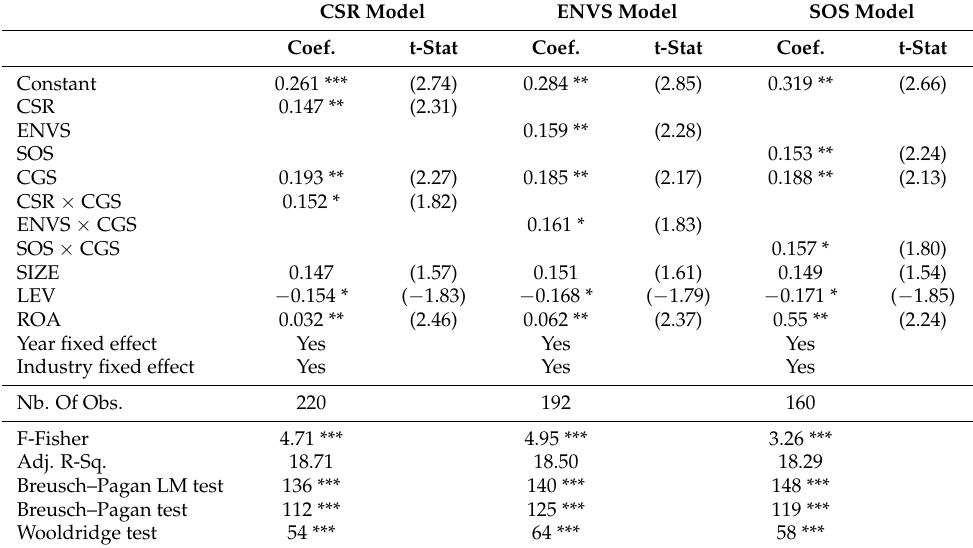
Table 3. Empirical